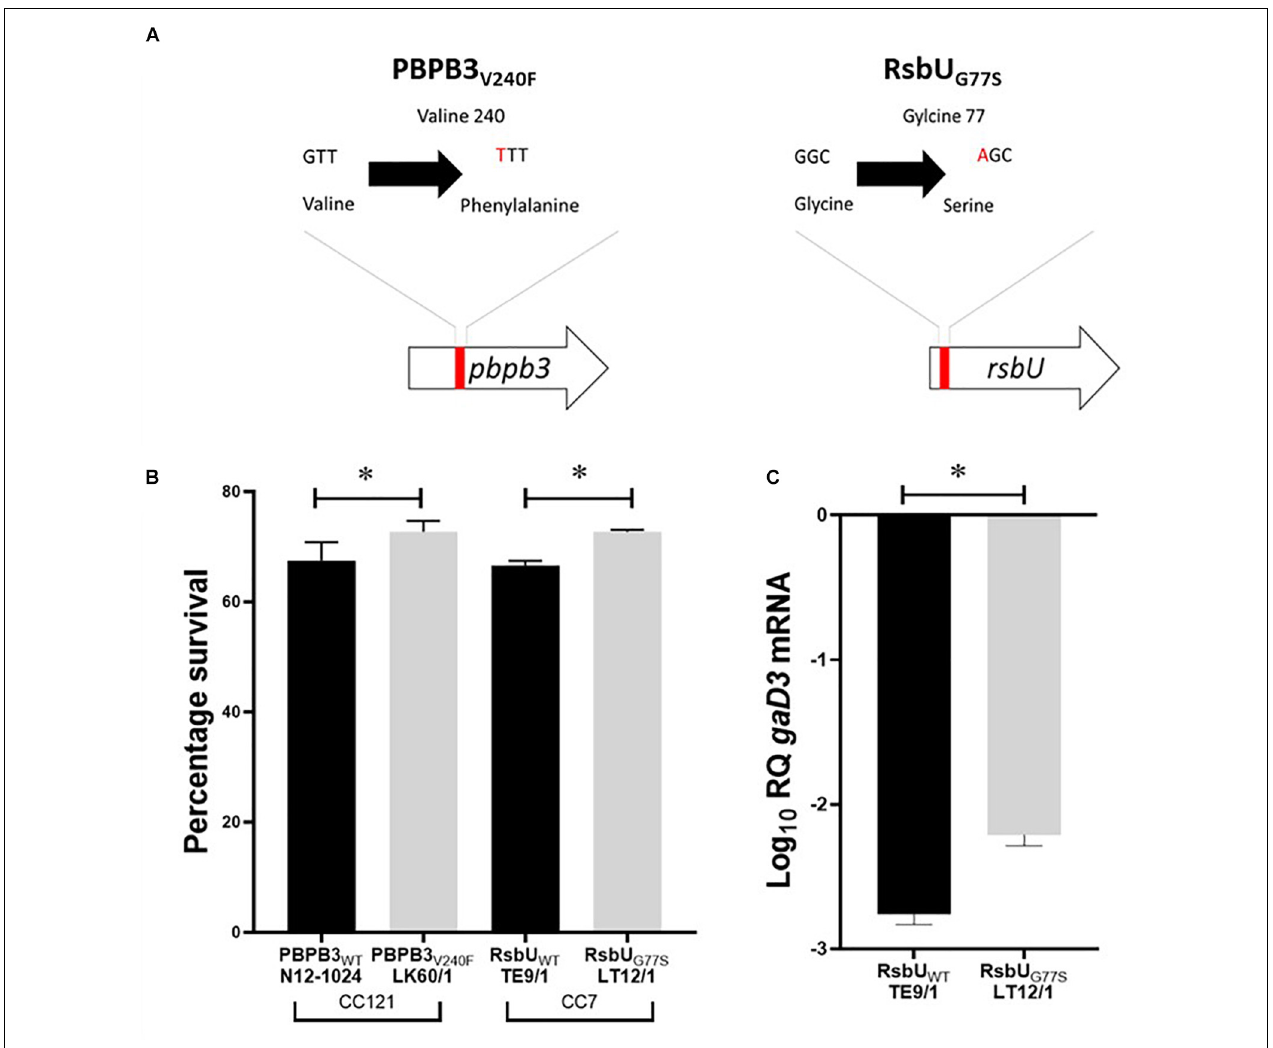
FIGURE 6 | (A) Schematic representation of the PBPB3 V240F and RsbU G77S mutations detected in nisin resistant L. monocytogenes field strains LK60/1 and LT12/1. (B) Triton X-100 stress survival analysis (C) RT-PCR quantification of gadD3 mRNA levels in exponentially growing L. monocytogenes cells cultivated in under nisin stress in BHI at 37 ◦ C. Data represents the mean and standard deviation from three independent biological experiments. * P < 0.05 significant difference between the strains based on pairwise t -test comparison for independent